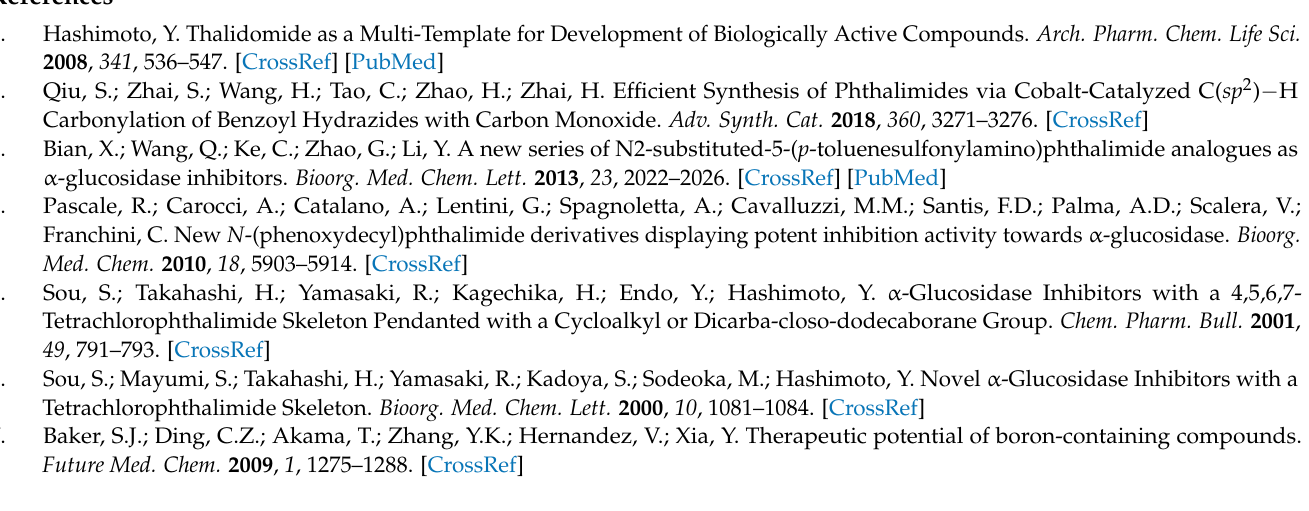
Figure S2: 13 C NMR spectrum of para 3 ; Figure S3: 1 H NMR spec-trum of mata 3 ; Figure S4: 13 C NMR spectrum of mata 3 ; Figure S5: 1 H NMR spectrum of ortho 5 ; Figure S6: 13 C NMR spectrum of ortho 5 ; Figure S7: 1 H NMR spectrum of meta 5 ; Figure S8: 1 H NMR spectrum of para 5 ; Figure S9: 13 C NMR spectrum of para 5 ; Figure S10: 1 H NMR spectrum of ortho 8 ; Figure S11: 13 C NMR spectrum of ortho 8 ; Figure S12: 1 H NMR spectrum of para 8 ; Figure S13: 13 C NMR spectrum of para 8 ; Table S1: Crystal data and structure refinement for meta 5 ; Table S2: Bond lengths [Å] and angles [ ◦ ] for meta 5 ; Table S3: Crystal data and structure re-finement for ortho 8 ; Table S4: Bond lengths [Å] and angles [ ◦ ] for ortho 8